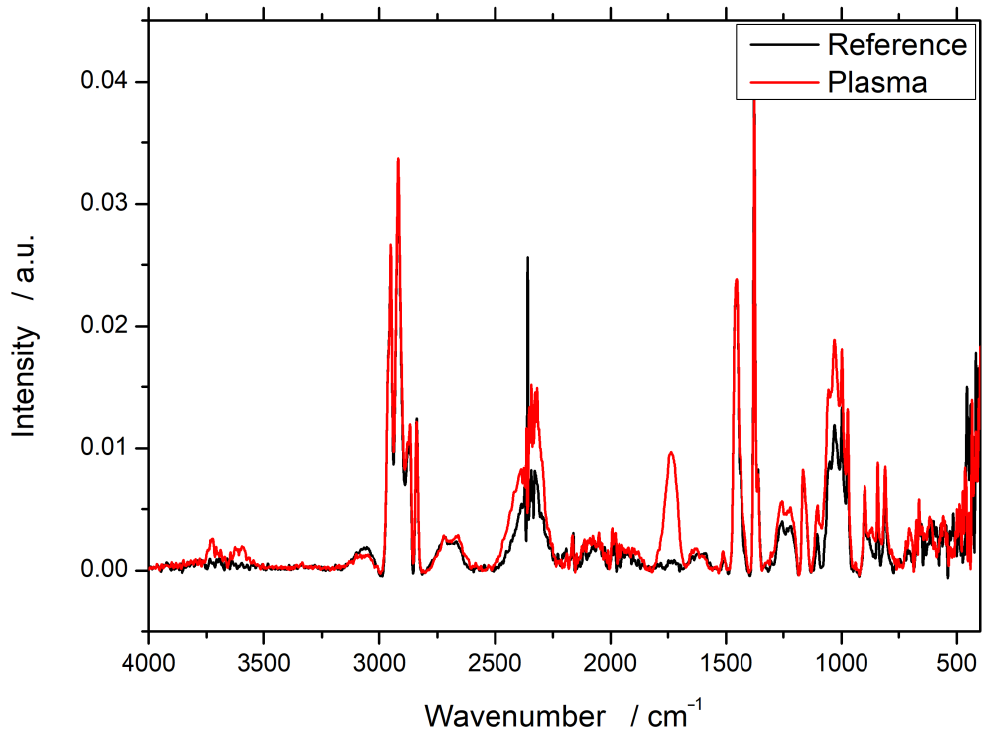
Figure 1. Fourier-transform infrared spectroscopy (FTIR) spectra of wood–plastic composites (WPC) with 60% wood content in polypropylene (PP) before and after plasma treatment with 90% argon and 10% oxygen as working gas.